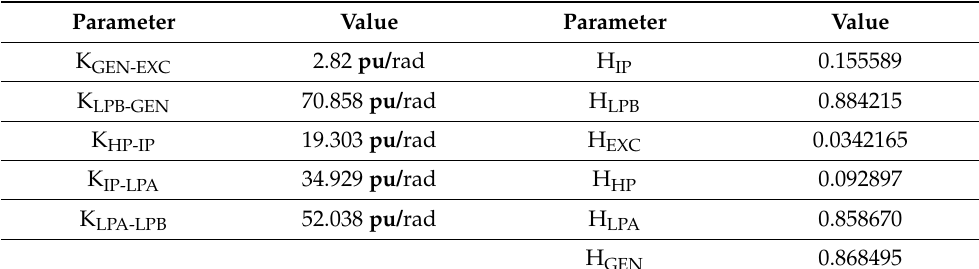
Table A1. Shaft Parameters.